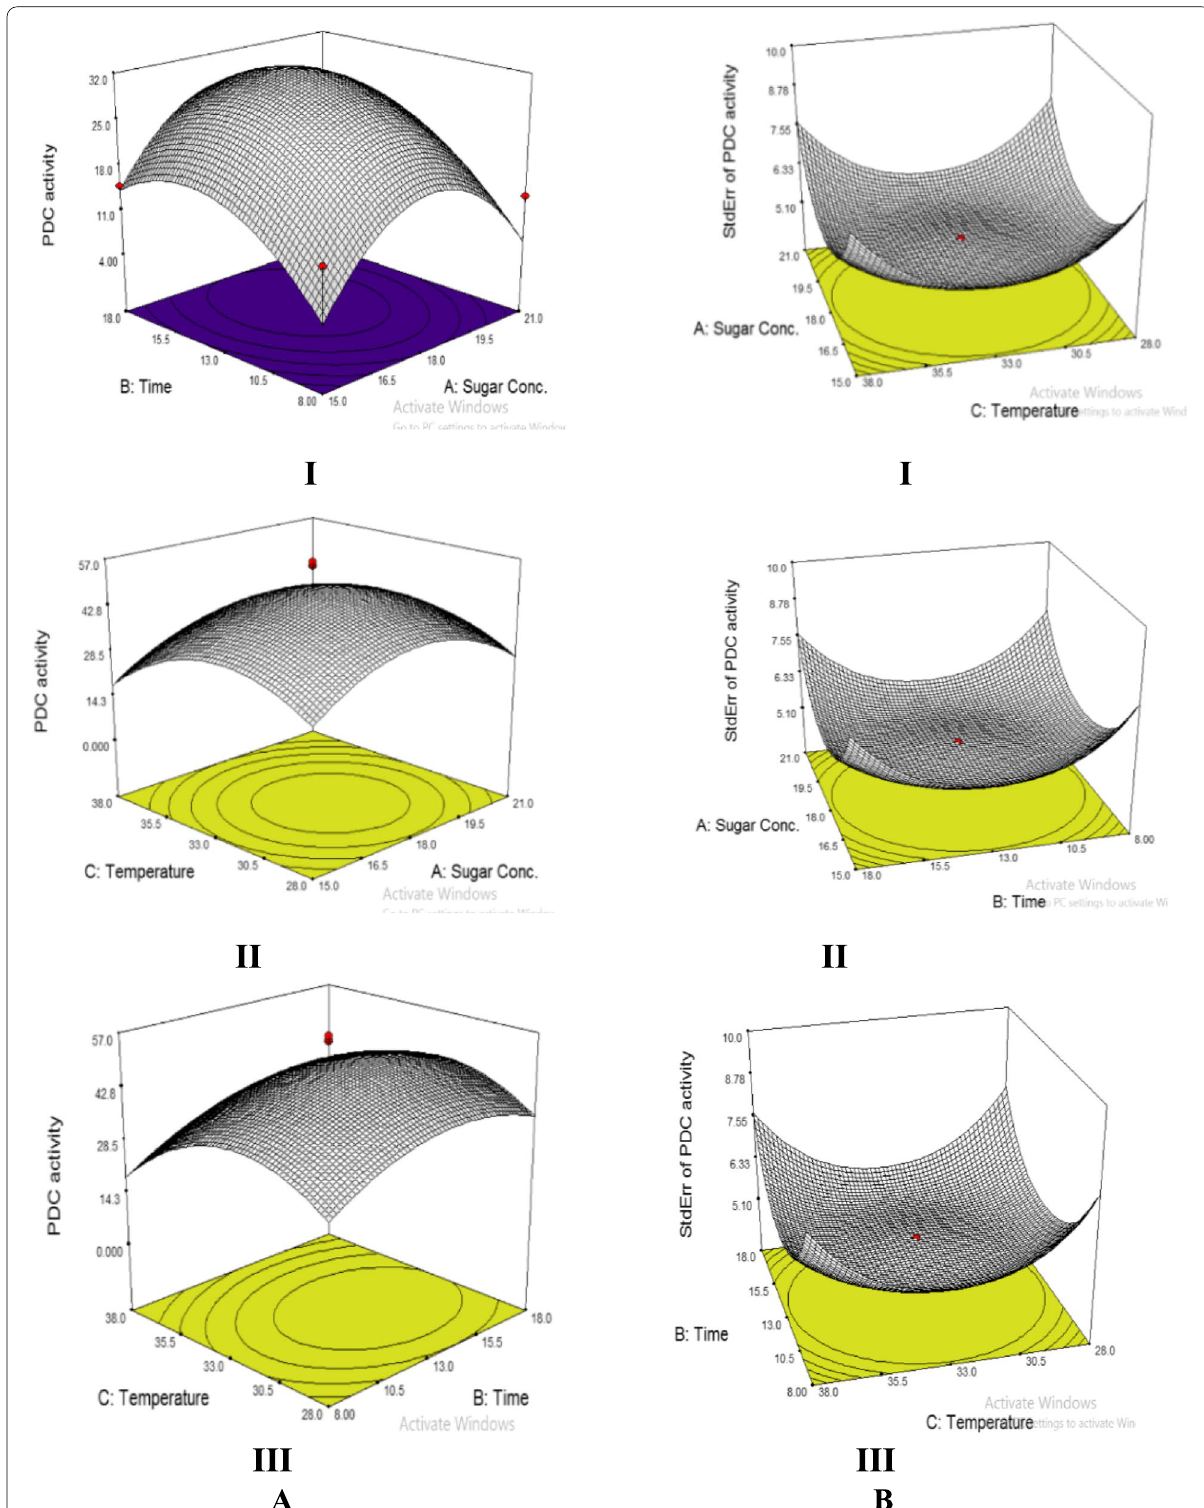
Fig. 4 A Effect of corelations of temperature (°C), time (h), and sugar conc. (% age) on PDC activity. B Standard errors for corelation of factors (temperature (°C), time (h), and sugar conc.